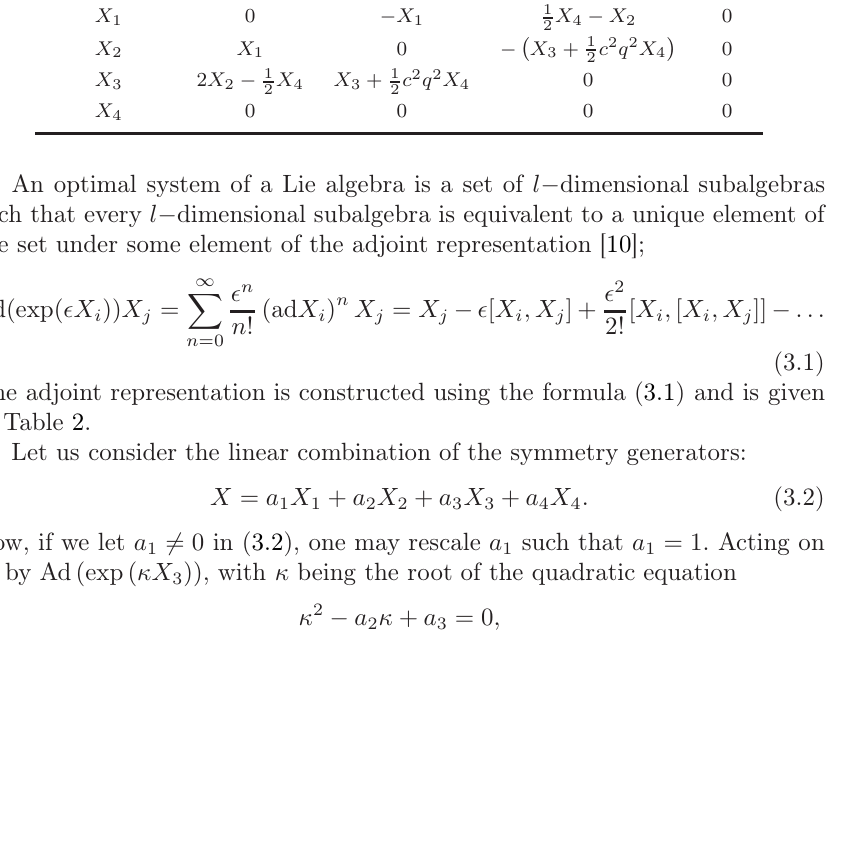
Table 1. Lie bracket of the admitted symmetry algebra, [ X